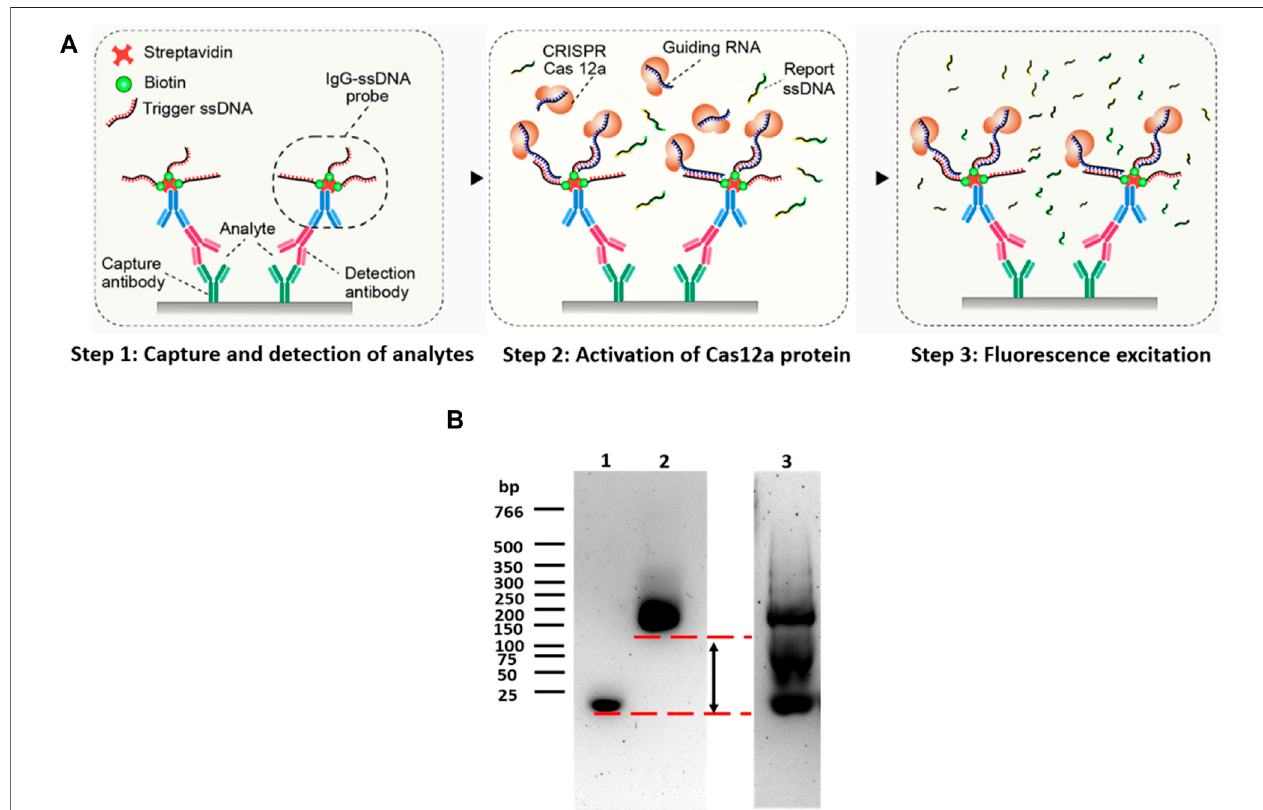
FIGURE1| Principle ofCANi. (A) Principle oftheCRISPR/Cas12a-assistednewimmunoassay(CANi). (B) Electrophoretic mobility shiftassay(EMSA).Lane1was triggering ssDNA, lane 2 was the IgG – ssDNA probe, and lane 3 was IgG – ssDNA probe before puri fi cation.